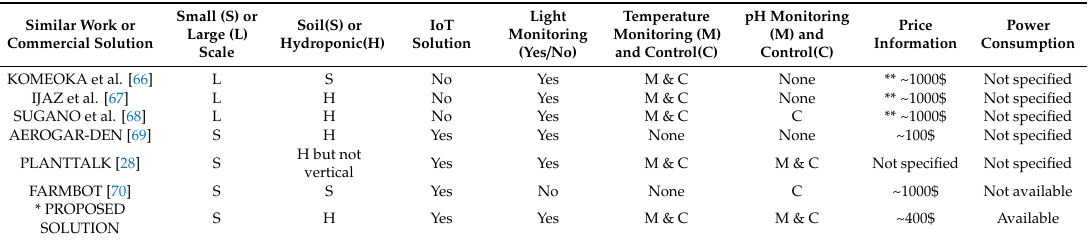
Table 2. Price and feature comparison of some research project and commercial